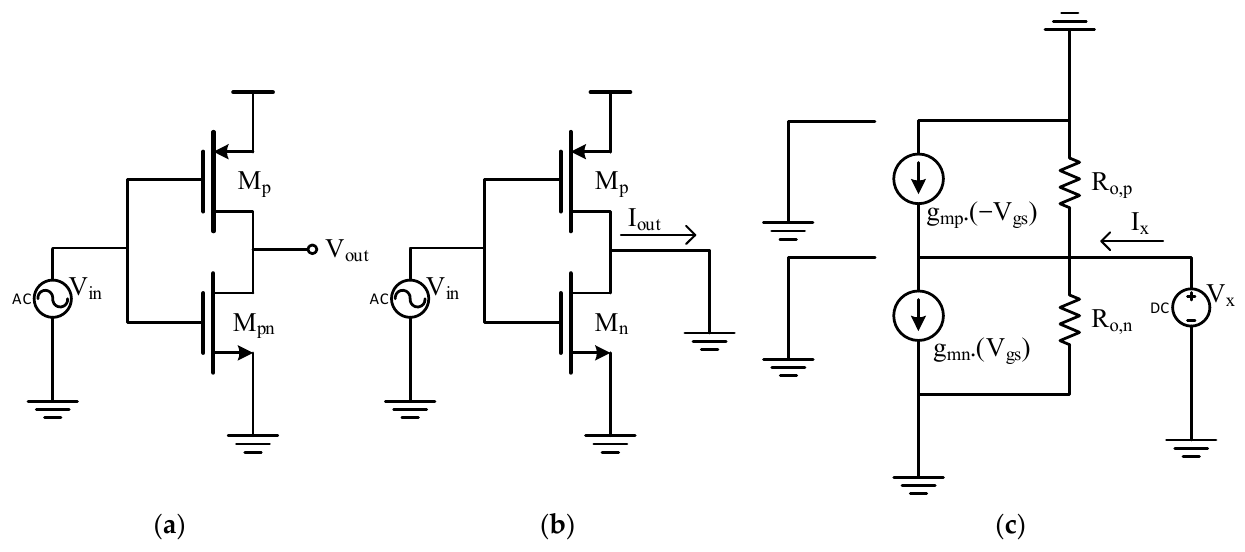
Figure 2. ( a ) Inverter-type current reuse circuit. ( b ) Scheme for transconductance calculation. ( c ) Equivalent small signal model for output resistance